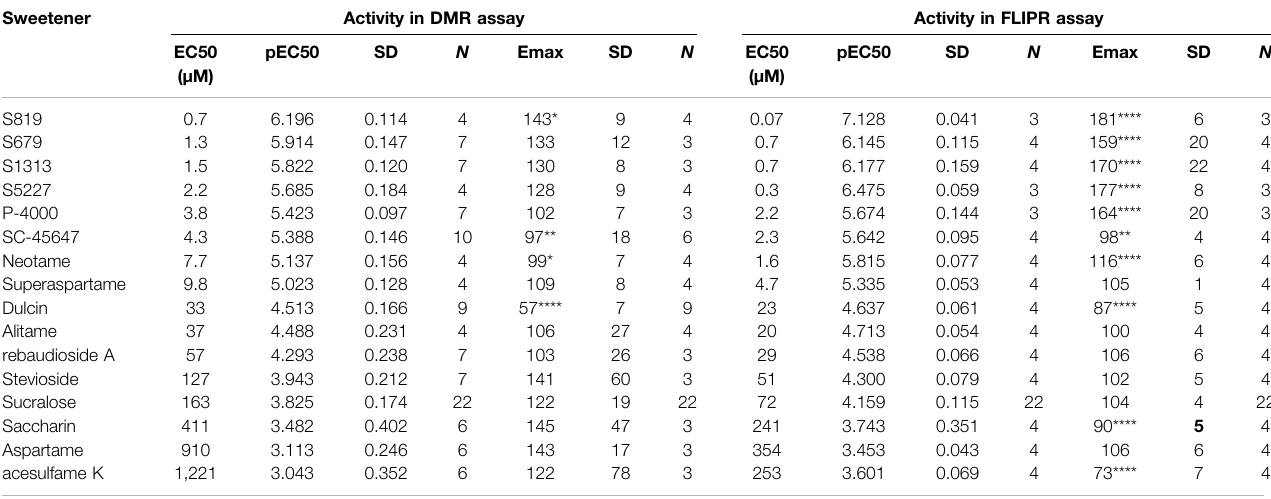
TABLE1| Summaryofpotencyandef fi cacyvaluesforsweettastereceptoragonistsusedinthisstudy.AgonistEmaxvalueswerecomparedtothatofsucraloseinthesame assay and analyzed by an unpaired, two-tailed t -test ( α = .05).